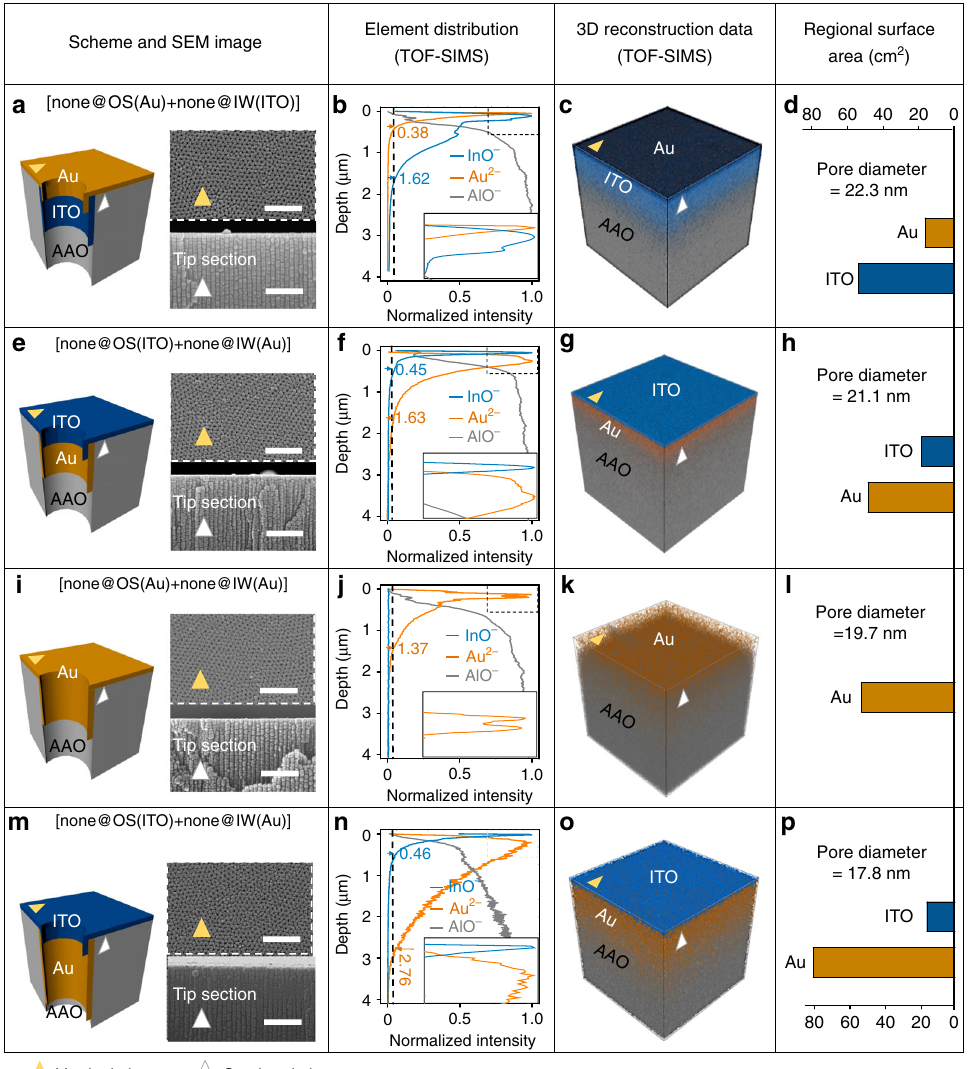
Fig. 2 Explicit spatial partition of OS and IW. We design four samples with varied stacking orders of Au and ITO as a [none@OS(Au) + none@IW(ITO)], e [none@OS(ITO) + none@IW(Au)], i [none@OS(Au) + none@IW(Au)] and m [none@OS(ITO) + none@IW(Au)] by atomic layer deposition (ALD). Corresponding SEM images taken from vertical and sectional view reveal that nanochannels remain open even after the deposition processes. The element distributions of the four samples are characterized by TOF-SIMS in b , f , j , and n , respectively. The depth with the 5% of the peak intensity is de fi ned as the start or the end of Au or ITO deposition (the gray dashed line in b , f , j , and n , respectively). Thus, the corresponding 3D reconstructions ( c , g , k , and o ) of the four samples are plotted from the intensity distribution of TOF-SIMS data. The surface area of Au and ITO on the OS or IW are calculated ( d , h , l , and p ) according to the element depth measured from TOF-SIMS and the pore size measured from SEM (Supplementary Fig. 5). Scale bars, 500